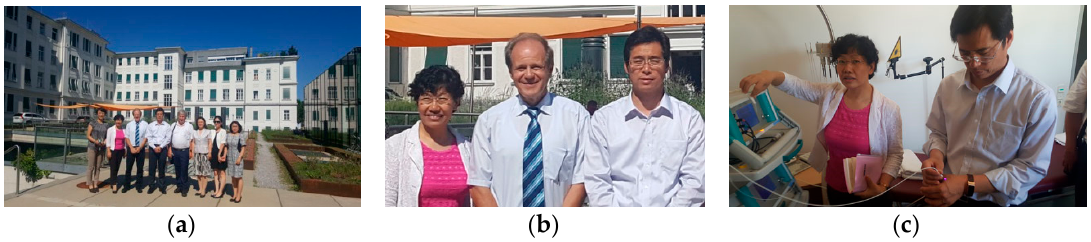
Figure 16. ( a – c ) Delegation from China Academy of Chinese Medical Sciences at the Medical University of Graz. ( b ) From left to right: Professor Jing Xianghong, Deputy Director of the Institute